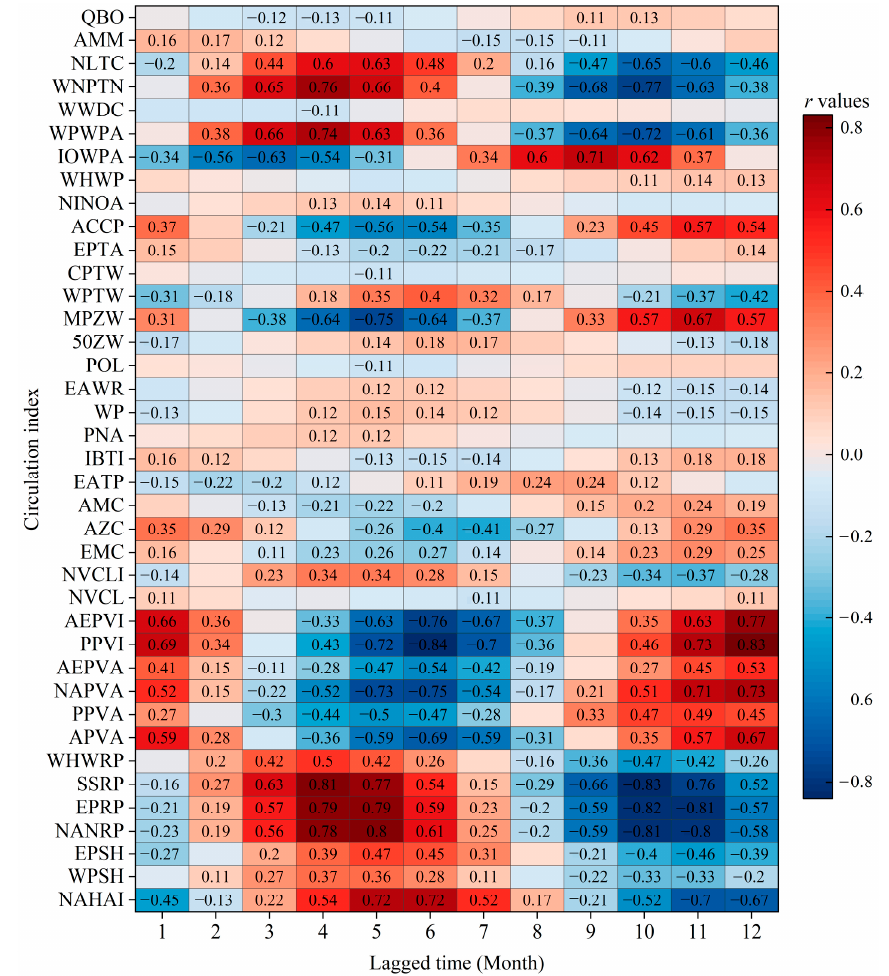
Figure 5. The r values at different lagged times (1–12 months) between monthly D and the specific circulation index (from the selected 39 ones) at the significance level of p < 0.01 for site no. 52118.